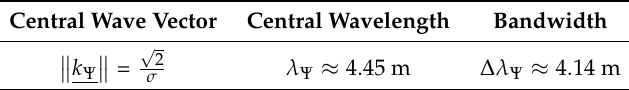
Table 2. 2D Mexican hat band-pass behavior ( σ =